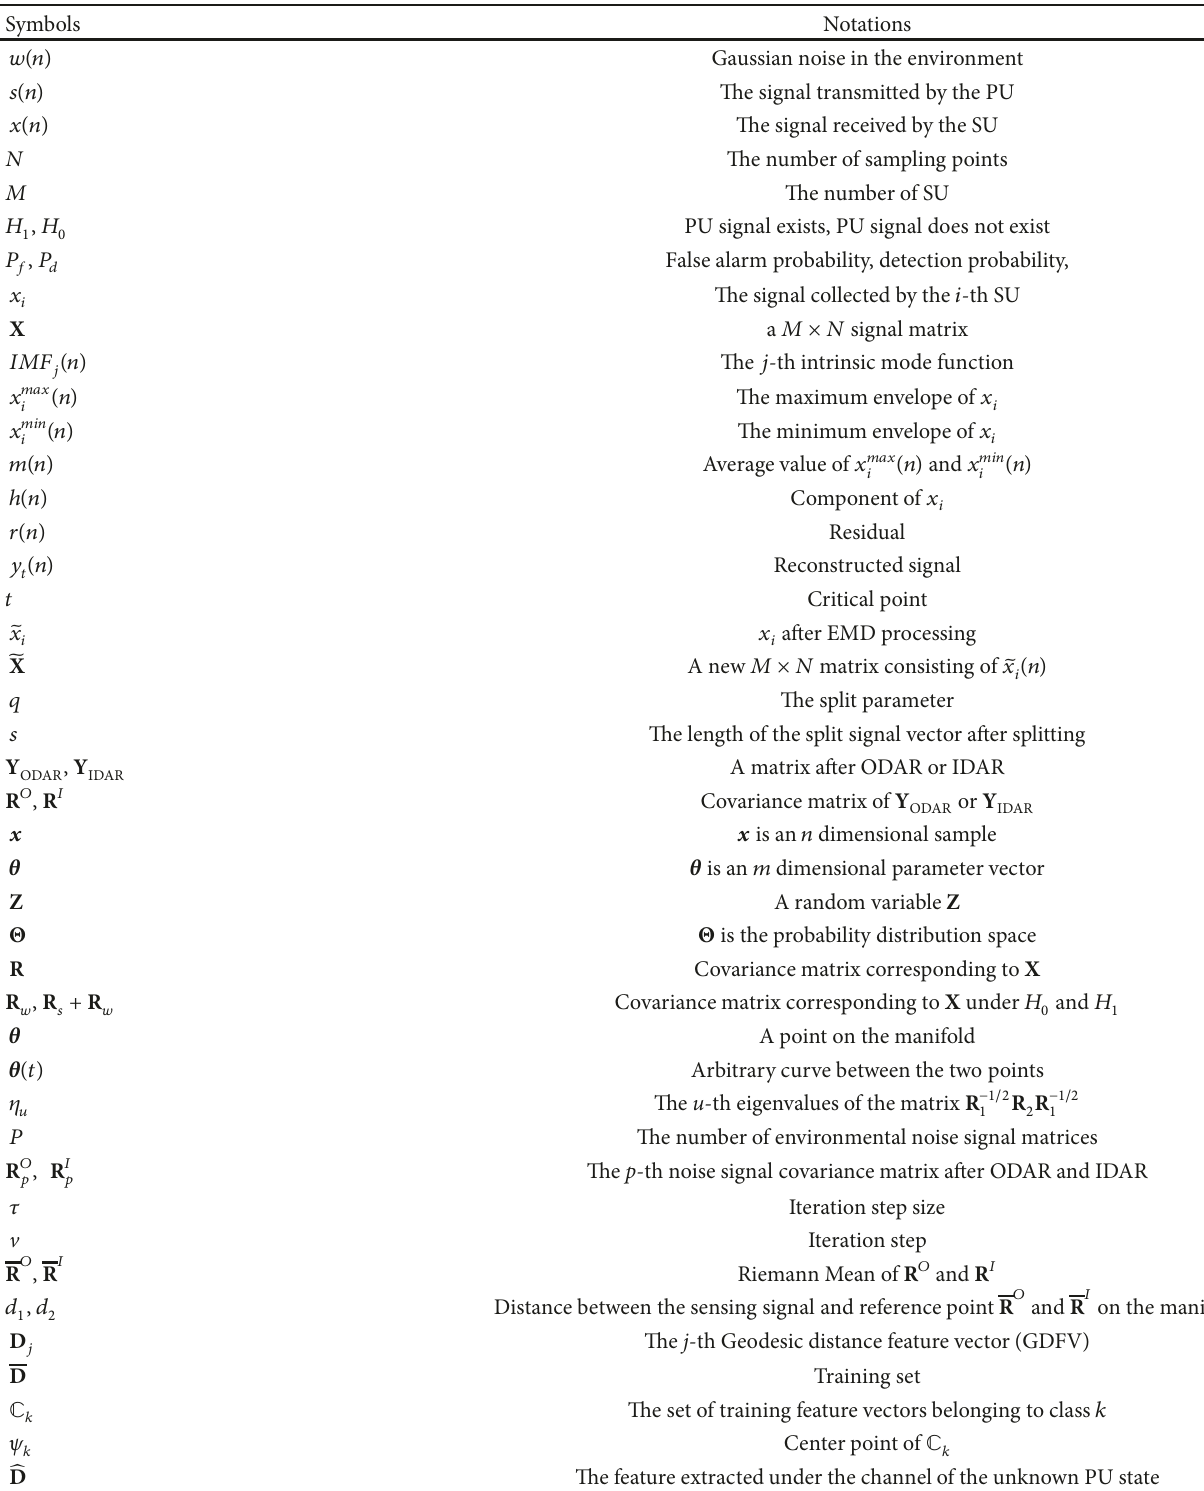
Table 1: Symbols and